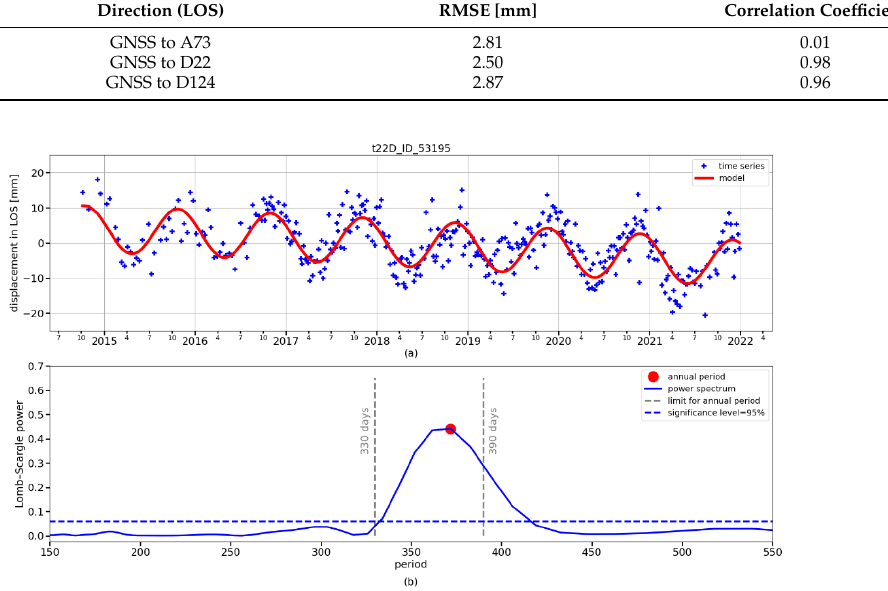
Figure 13. Time series of the displacement of PS point 53,195 (track D124) in LOS and model based on period-gram ( a ): blue crosses show the PS time series; the red line shows the model created according to the significant period shown by the red point in the graph ( b ), which shows the corresponding Lomb–Scargle periodogram. The significant periodicity of the point was identified with a period of around 372 days. (Adjusted according to [26] (processed longer time